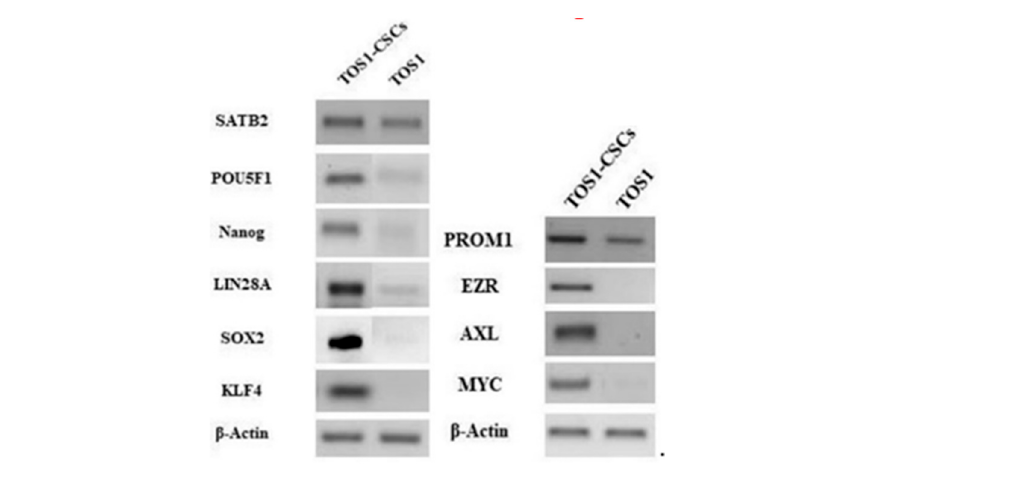
Figure 10. Gene expression in isolated RT-PCR showed the expression of SATB2 and PROM1 gene in TOS1 primary cell culture and in the isolated TOS1-CSC cell line. In addition to this, RT-PCR also showed the expression of the ESC marker genes and of EZR, AXL and MYC only in the TOS1-